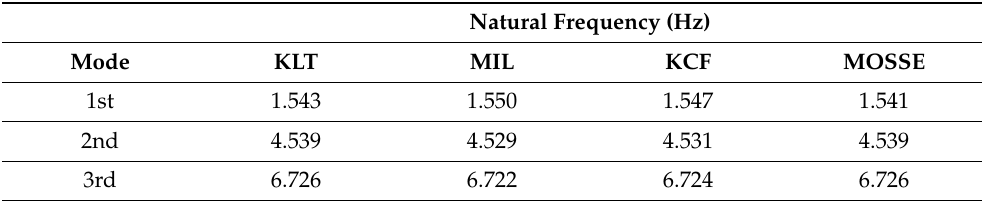
Table 2. The natural frequency for different object tracking algorithms.